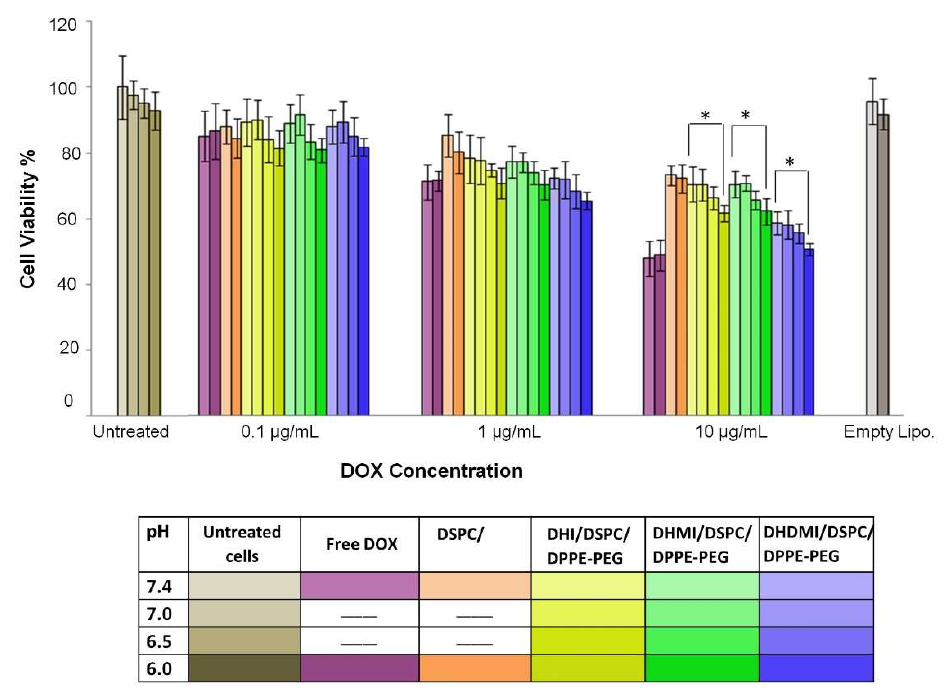
Figure 9. Cell viability of 2D HeLa cells treated with free DOX, cholesterol-free ICL and pH-insensitive liposomes at pH 7.4, 7.0, 6.5, and 6.0 for 12 h. Data are presented as mean ± SD, N = 4. * p < 0.05. pH was adjusted in the growth media.